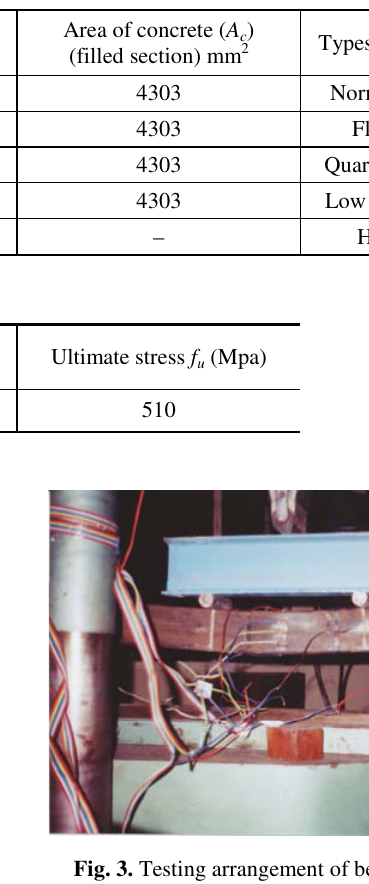
Fig. 3. Testing arrangement of beam